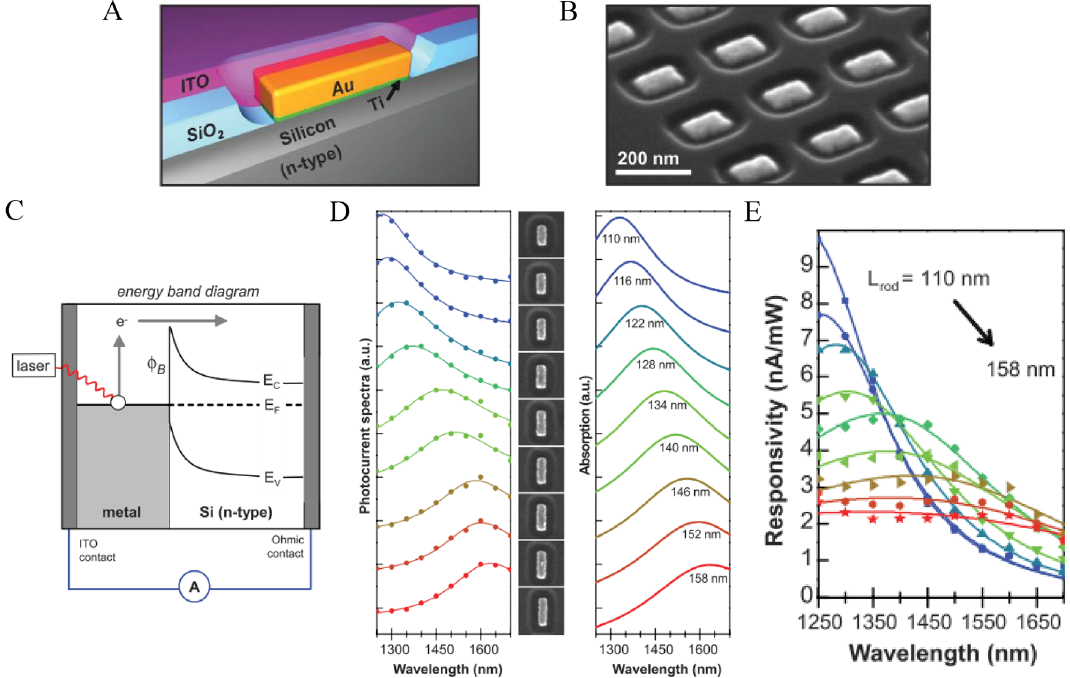
Figure6: (A)SchematicrepresentationofAunanoantennaonann-typeSisubstrate.(B)SEMimageofanactiveopticalantenna-baseddevice (imaged at a 65 o tilt angle). (C) Energy band diagram of the active optical antenna Schottky-based devices. (D) The measured photocurrent spectraandsimulatedabsorptionspectraof the nanoantennasfeaturingdistinctsizes.(E)The measuredspectralphotoresponsivityof active optical antenna-based devices featuring different dimensions of Au nanoantennas (length: 110, 116, 122, 128, 134, 140, 146, 152, and 158 nm) [41]. Copyright 2011, American Association for the Advancement of